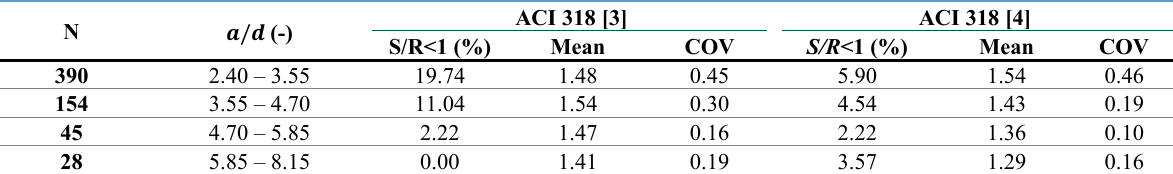
to ACI 318 [3] (yellow) and ACI 318 [3] 𝑀𝑀 / 𝑑𝑑